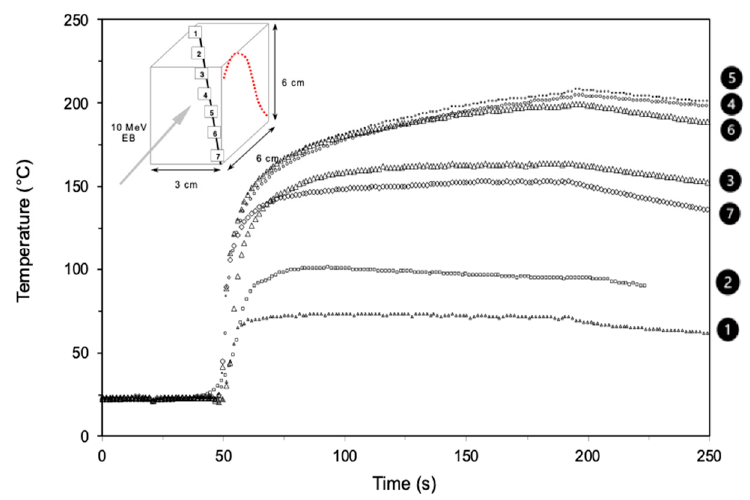
Figure 5. Position of thermocouples in a 125 g EPAC resin sample contained in a thin-walled aluminum box to (dotted line indicating the dose-depth deposition profile) and plots of the variations of the temperature in the sample submitted to a 50 kGy dose of 10 MeV electrons.